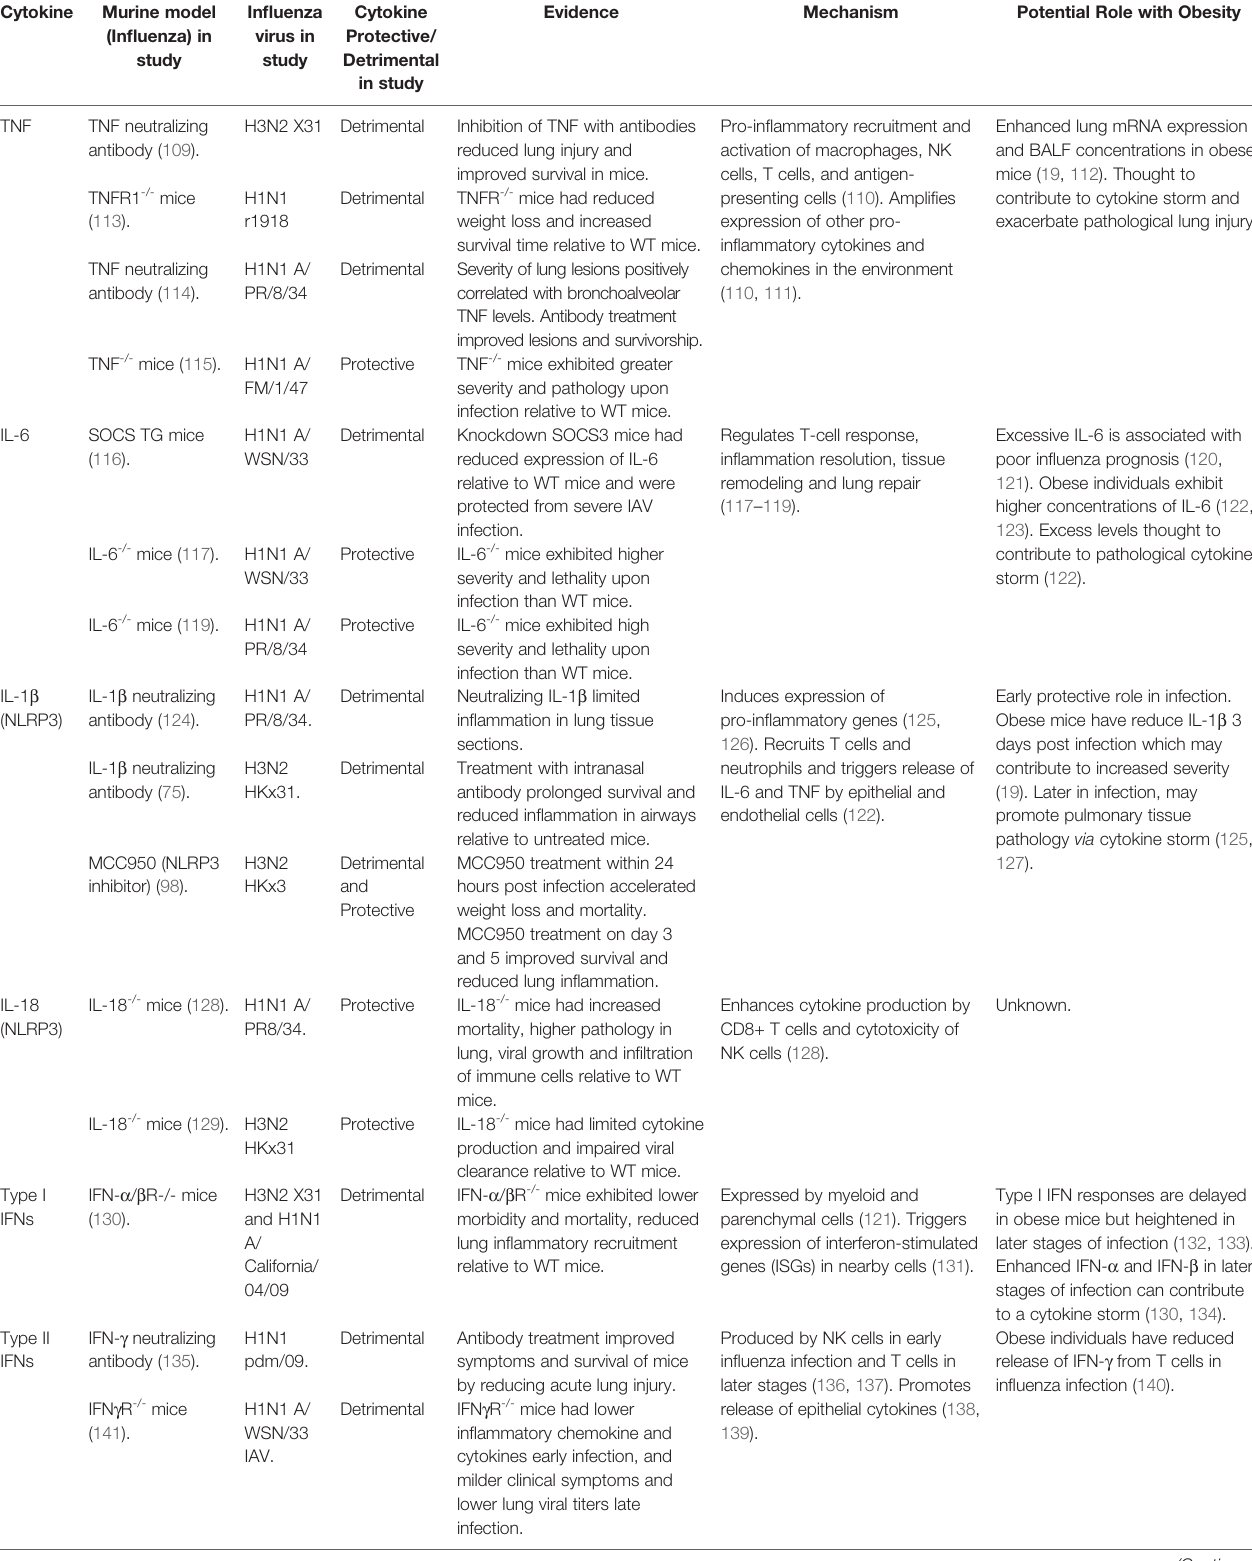
TABLE 1 | Cytokines in disease severity in In fl uenza and SARS-CoV-2